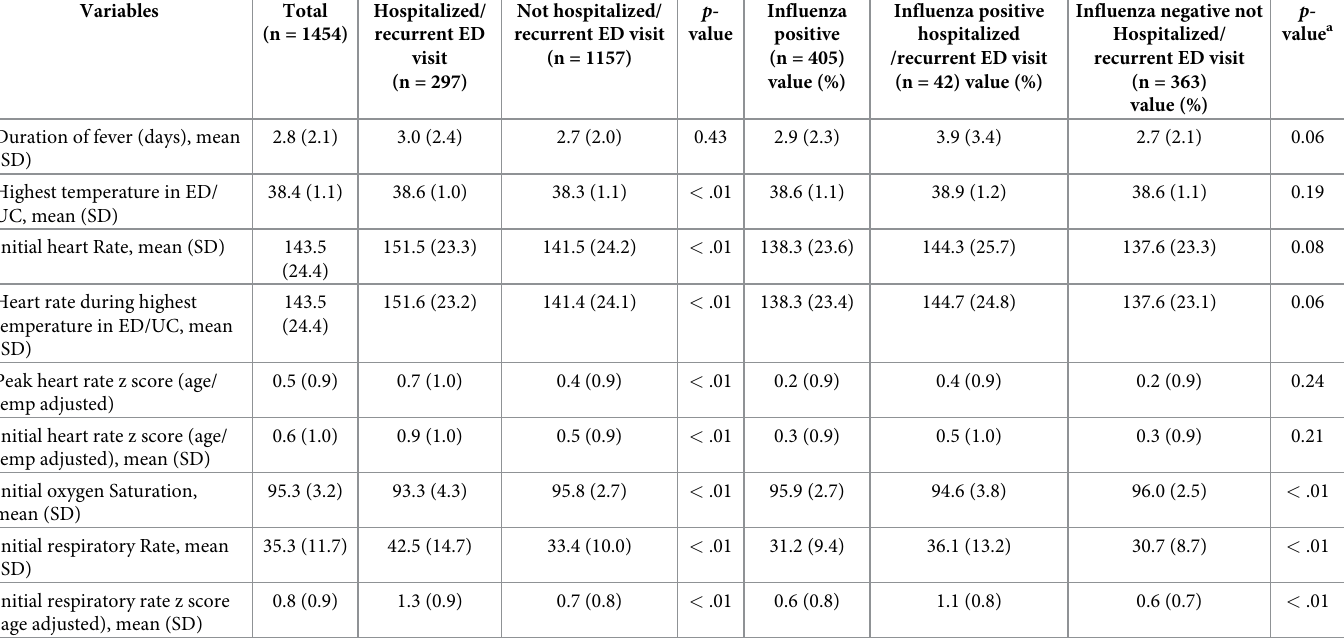
Table 2. Predictive value of vital sign data on hospitalization or recurrent ED visit within 72 hours among children with ILI and PCR-confirmed influenza evalu- ated in an ED and urgent care setting- bivariable analyses.